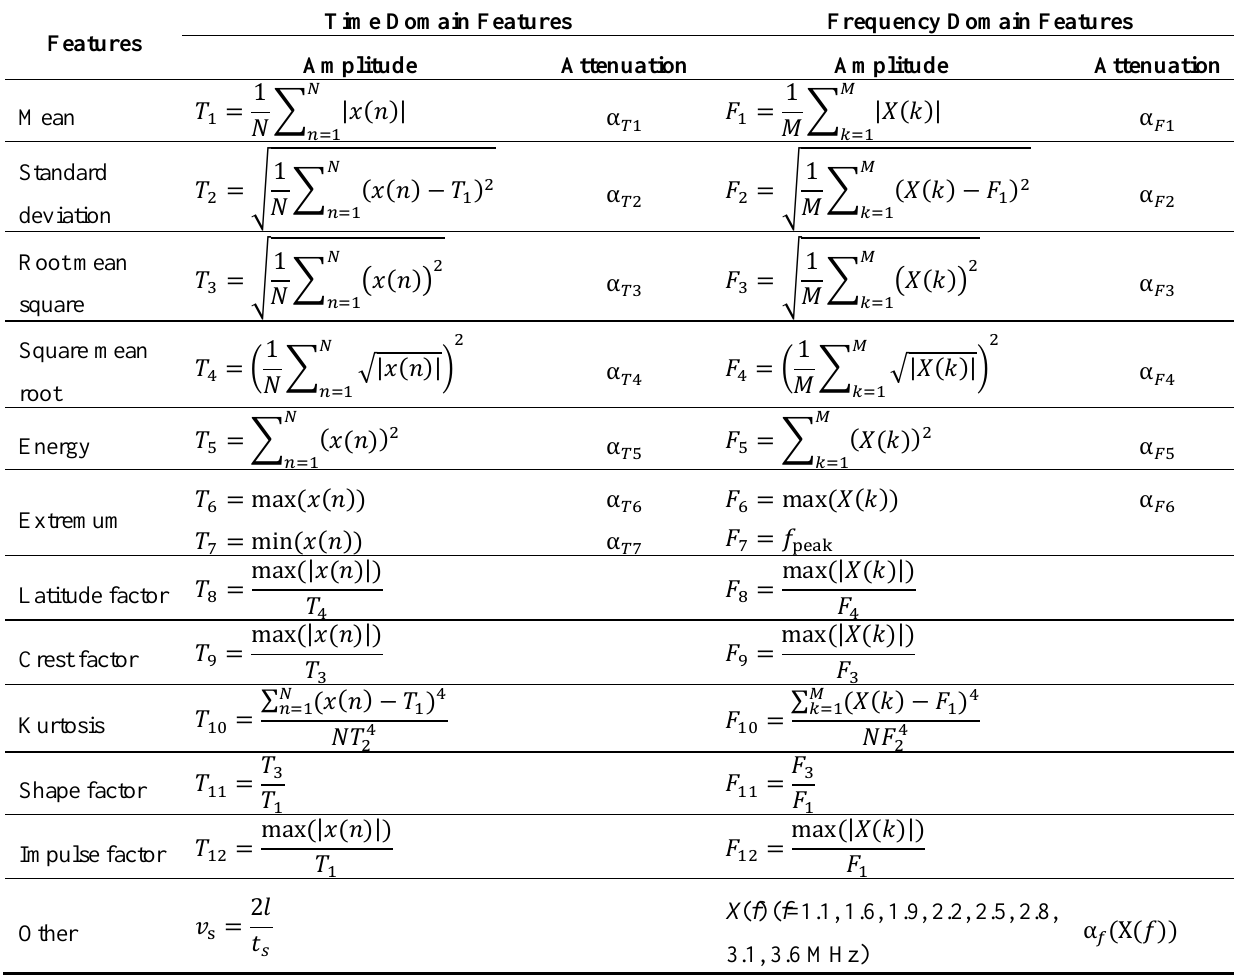
Table 1. The features extracted from ultrasonic